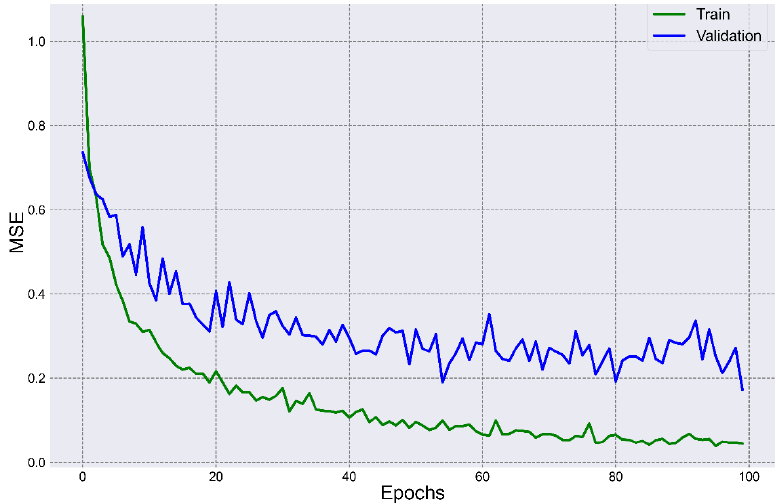
Figure 4. Comparison of loss function results ( MSE ).